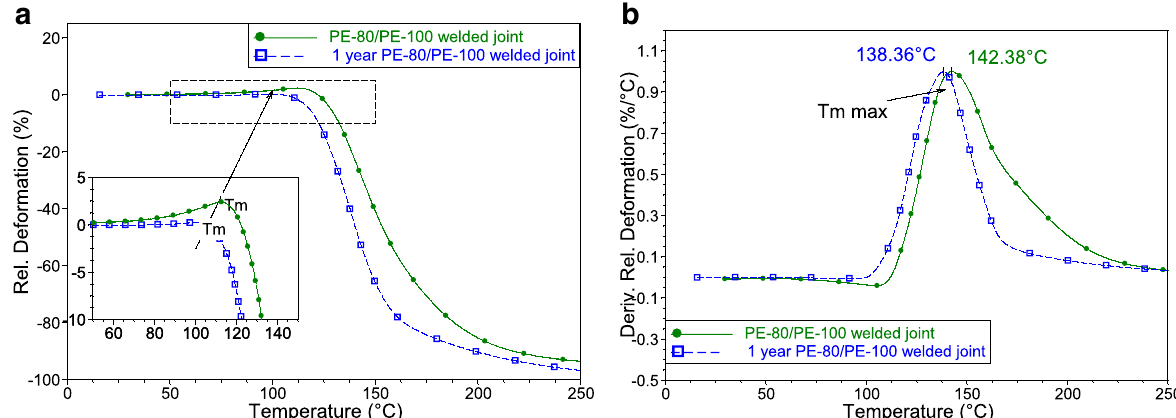
Fig. 7 Result of TMA study. Related deformation ( a ) and derivate related deformation on temperature ( b ) of PE-80/PE-100 welded